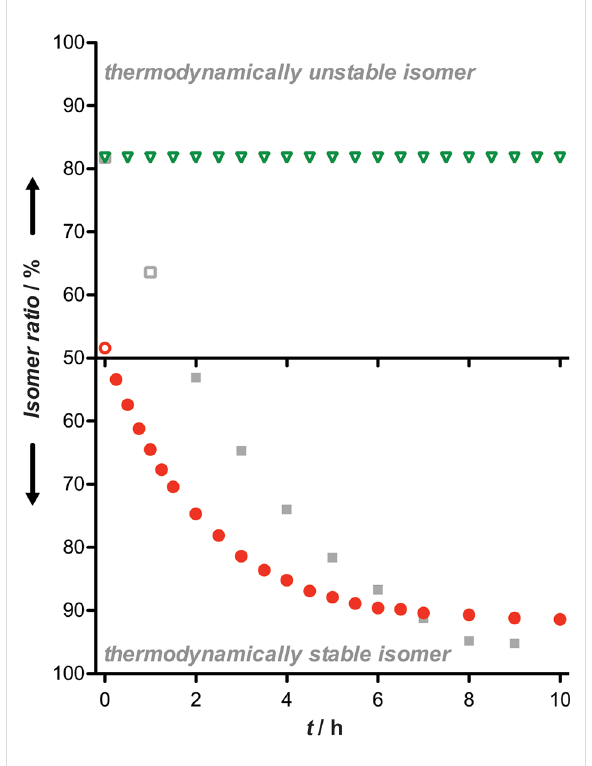
Figure 2: Time-dependent conversion to the thermodynamically stable isomer of PNA 12 ( o F 4 Azo) ( 3 ; green triangles) and PNA 12 (HTI) ( 4 ; red circles). 20 µM solutions of the corresponding compound in phosphate buffer (10 mM NaH 2 PO 4 , 150 mM NaCl, pH 7.4) were irradiated to obtain maximal cis ( o F 4 Azo, 520 nm, 10 min) or trans (HTI, 405 nm, 2 min) and stored in the dark. PNA 12 ( o F 4 Azo) ( 3 ) was also